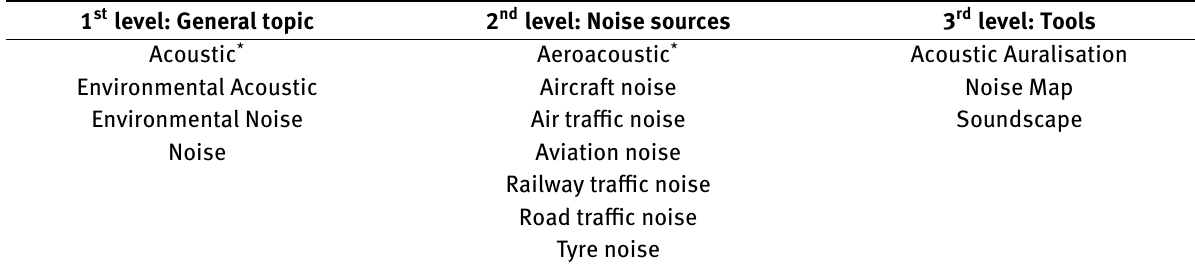
Table 1: Multilevel search structure. 1 st level: General topic 2 nd level: Noise sources 3 rd level: